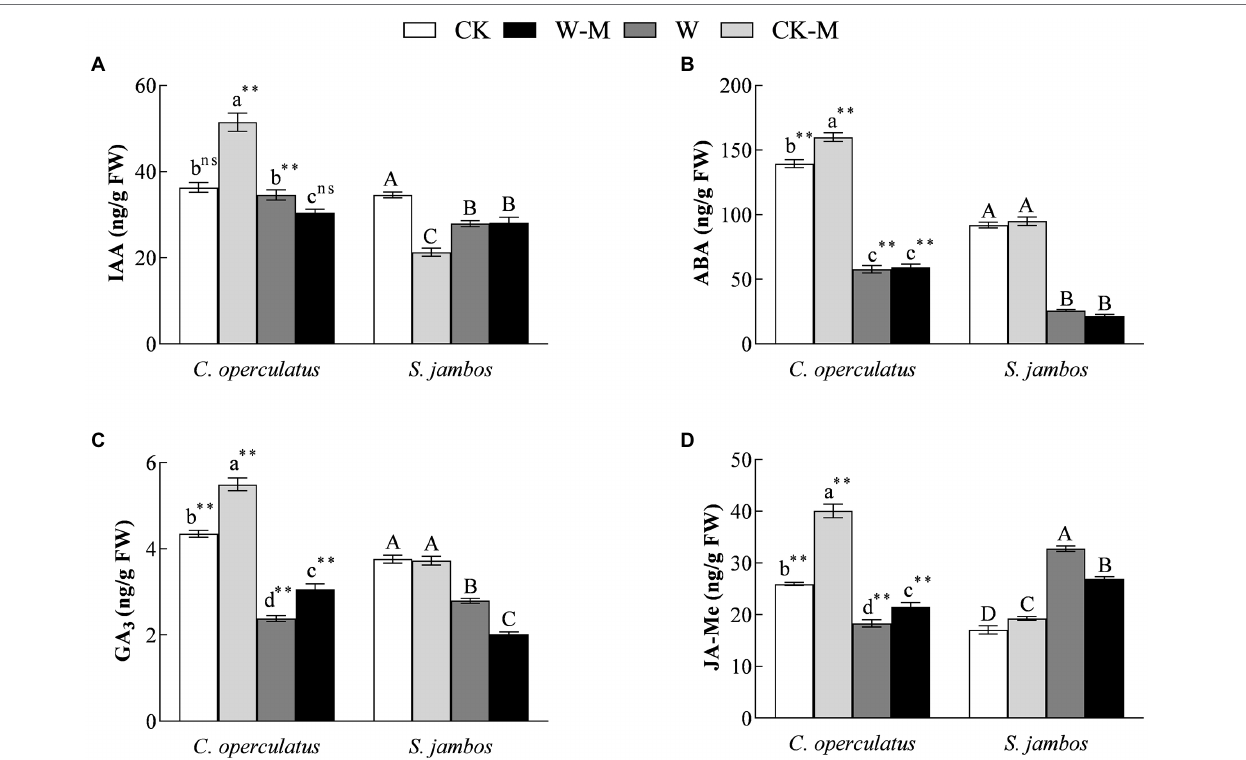
FIGURE 6 | The variations of IAA (A) , ABA (B) , GA 3 (C) , and JA-Me (D) in Cylindrocopturus operculatus and Syzygium jambos among different treatments. Values are means ± SE ( n = 6). Different little and capital letters indicate significant differences among different treatments within the same species according to ANOVA’s test ( p < 0.05). CK, pure planting pattern under well-watered condition; CK-M, mixed planting pattern under well-watered condition; W, pure planting pattern under waterlogging condition, W-M; mixed planting pattern under waterlogging condition. The signs such as ** and ns concern the significance difference between the two species under the same treatment. ** p < 0.01; ns,